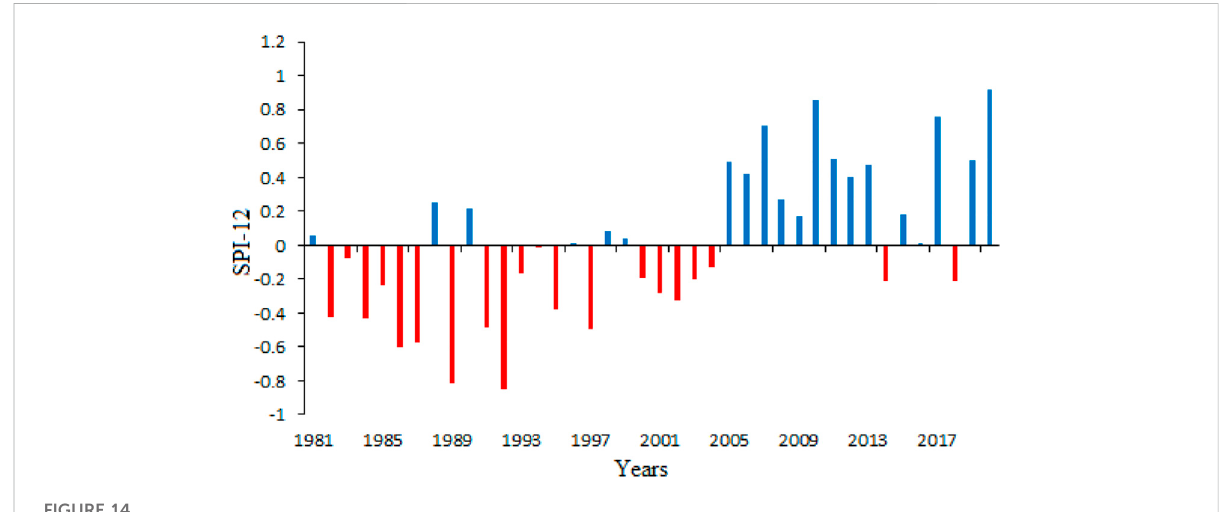
FIGURE 14 SPI-12 for SEA during 1981 –